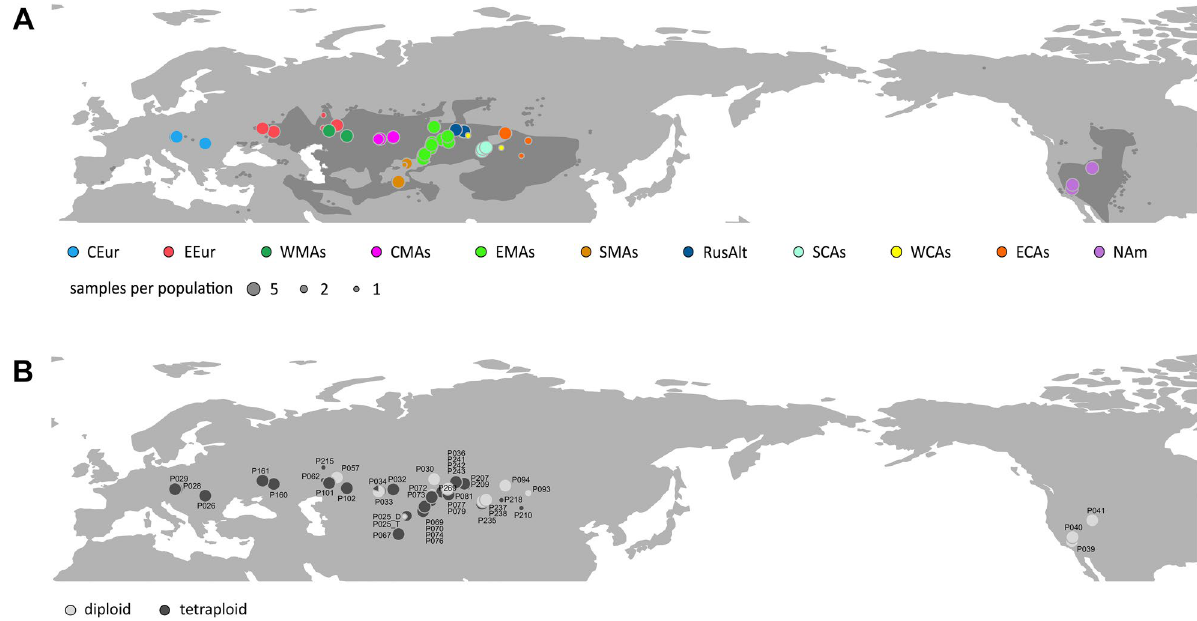
Figure 1. Population sampling of Krascheninnikovia ceratoides . Up to five individuals per population were used, as indicated by dot size. ( A ) The colour coding indicates the assigned geographical region of the